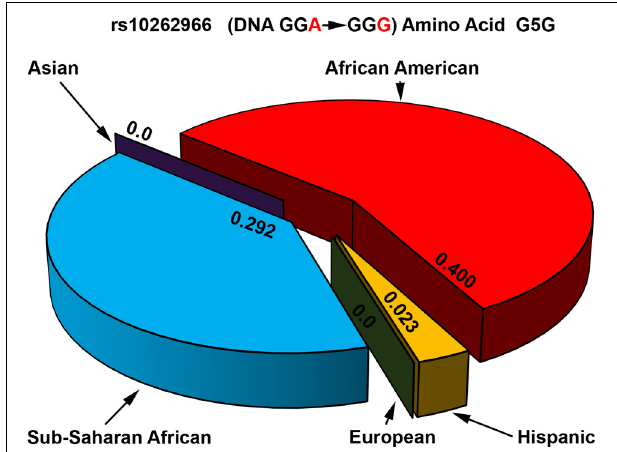
FIGURE 8 | Allele frequencies of POR variant G5G associated with increased breast cancer risk. The p.G5G variant of POR (rs10262966) is associated with increased risk of breast cancer when present in homozygous form in African Americans (Haiman et al., 2007). Genomic data from various sequencing projects show a clear pattern for the presence of rs10262966 in different populations. In the Caucasian and Asian populations rs10262966 is not present, while in Hispanic population it is present with a minor allele frequency of 0.023. In the Sub-Saharan African population the rs10262966 frequency is higher at 0.297 while in African Americans it is present in 40% of all alleles. Data were compiled from information available in NCBI SNP database as of April 2014